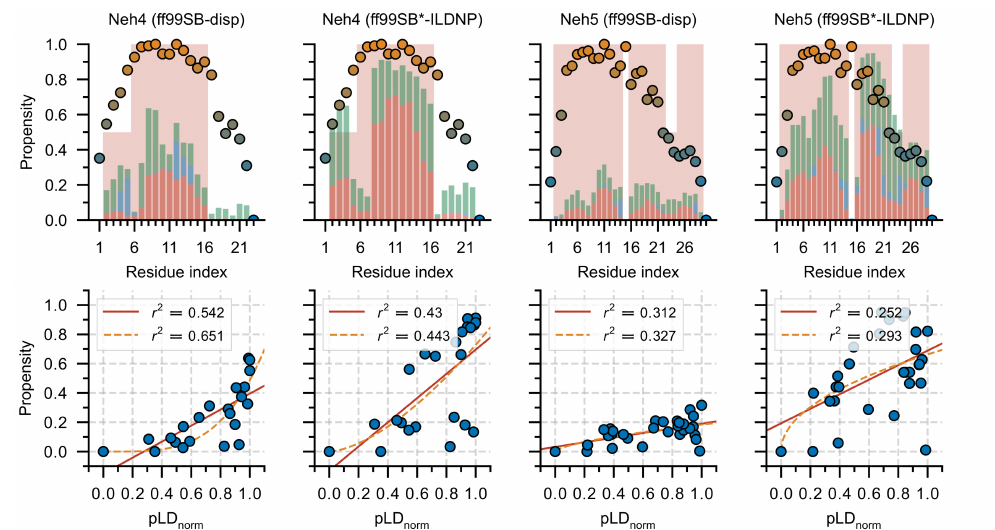
Figure 5. Secondary structure of ensembles versus AF2. Top : Secondary structure was computed from molecular simulation (red = α -helix, 3 10 -helix or π -helix; blue = β -strand or β -bridge; and green = turn). The red background color depicts the AF2 predicted secondary structure propensities, no strand/turn content was predicted. Bottom : Min–max normalized pLDDT values (pLD ) norm = 1 and blue implies are plotted (circles) with colors ranging from 0 to 1 (orange implies pLD norm = 0). We plot correlations between the total secondary structure propensity computed from pLD norm MD simulations and the pLD , and fit the data to a line (red) or a power law (orange). pLDDT is norm abbreviated pLD for plotting purposes.